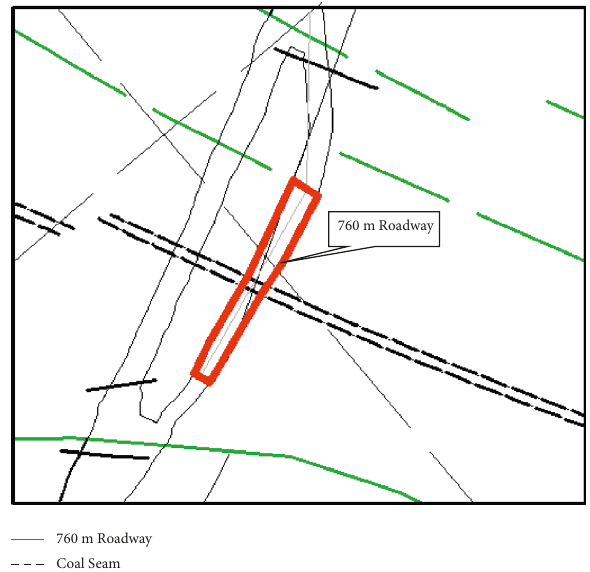
Figure 3: Location of the roadway and coal